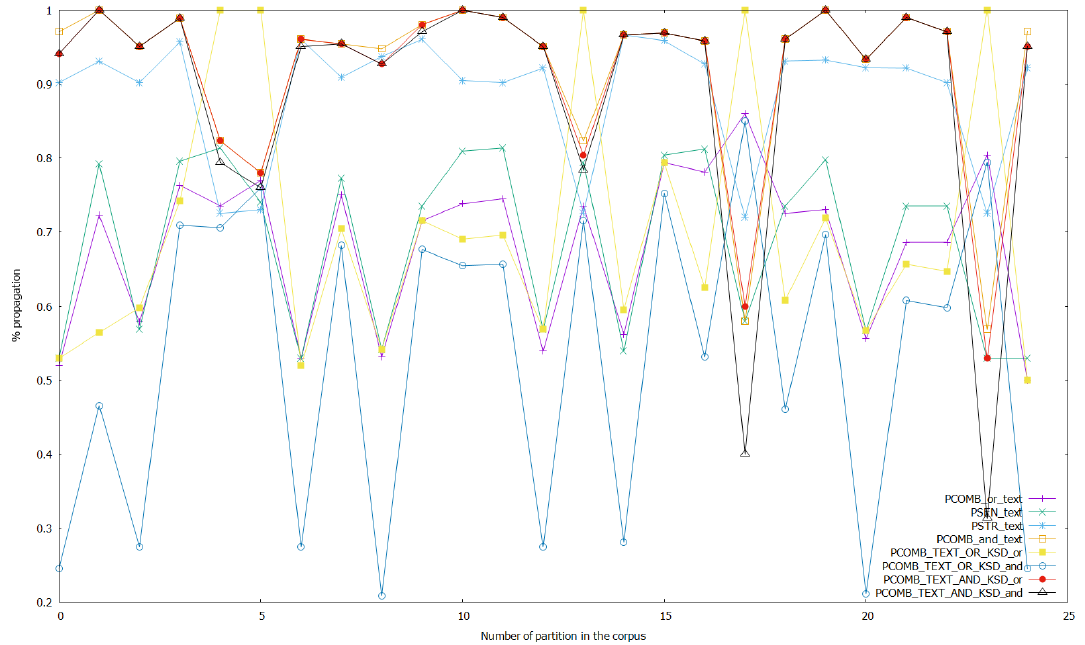
Figure 4. Results of the experiments with the sentiment, stress, and combined analyses on text, and with the combined analyses on text and keystroke data with thresholds unaltered.